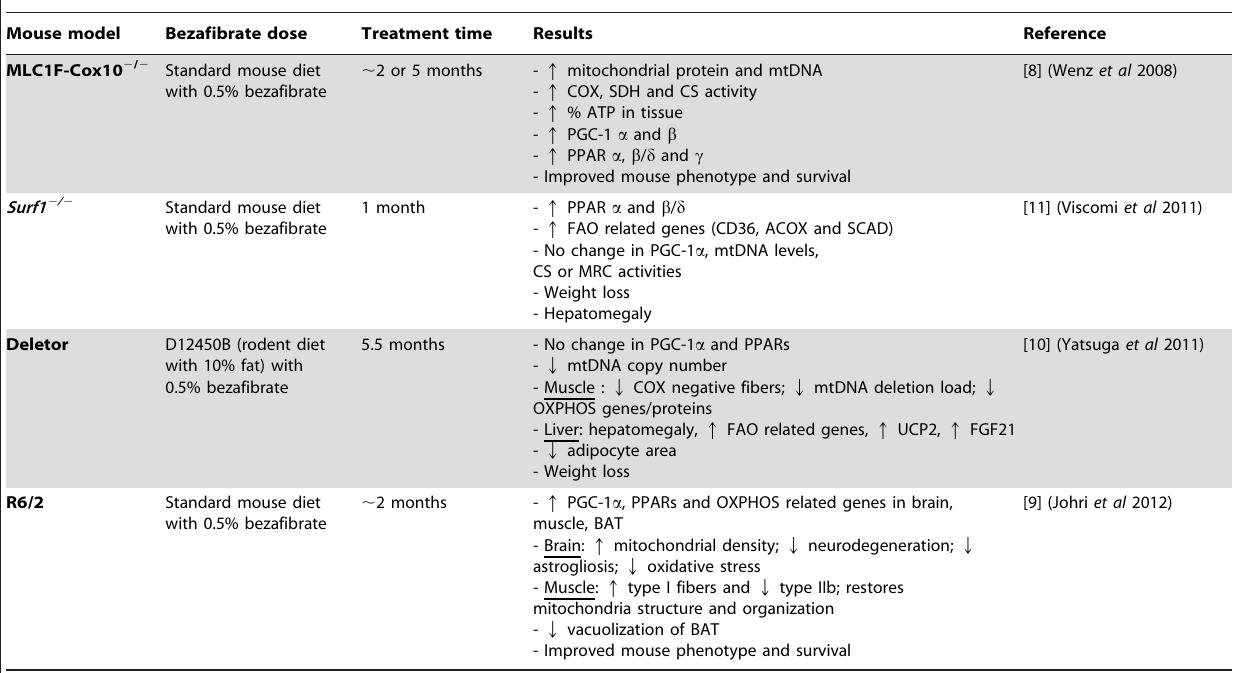
Table 1. The effect of bezafibrate treatment in mouse models of disease.